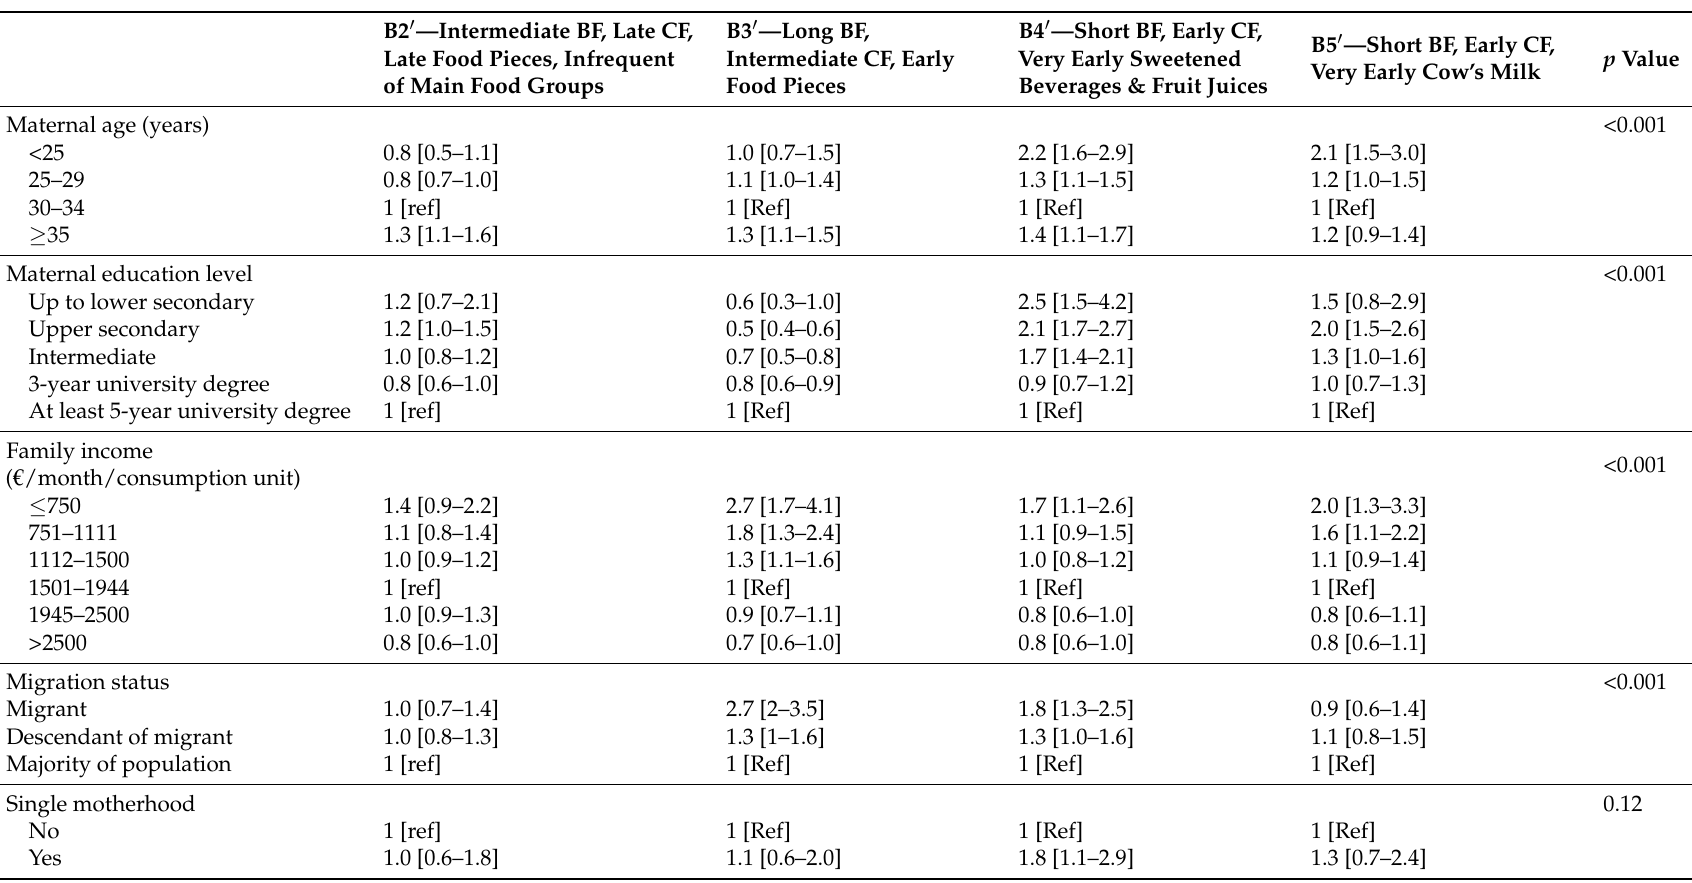
Table 6. Multivariable multinomial logistic regression analysis explaining clusters (identified by HAC) by family characteristics ( n =